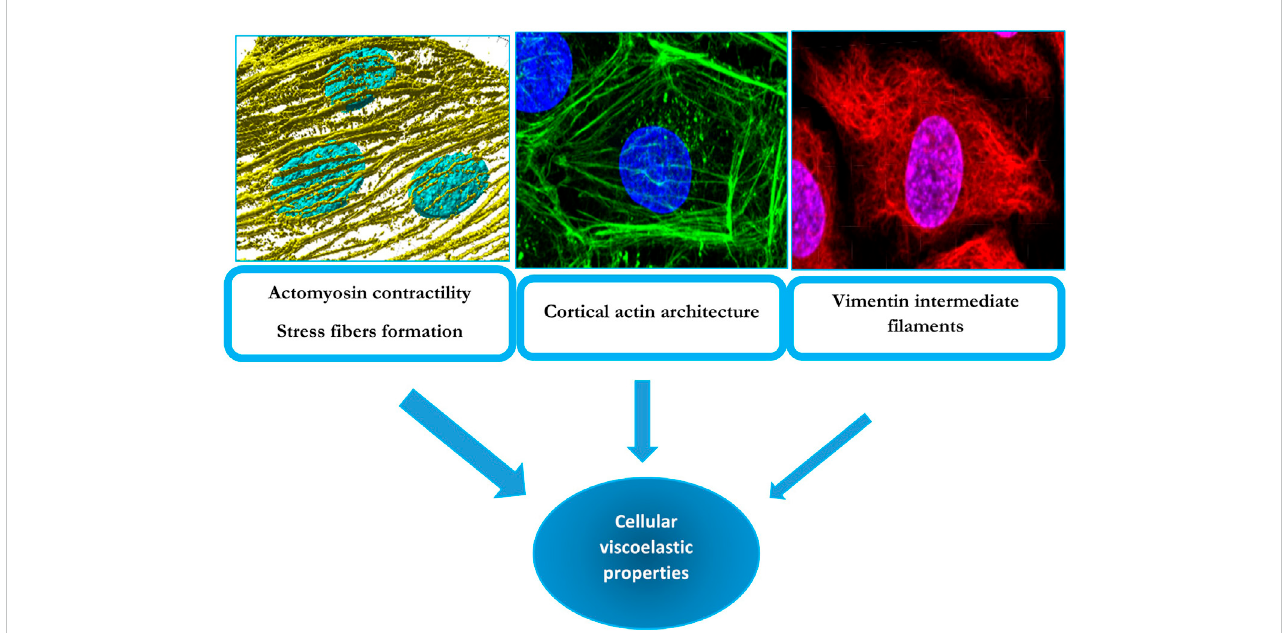
FIGURE 1 Cytoskeletal determinants of cellular viscoelastic properties: F-actin stress fi bers (left top panel), cortical actin (middle top panel) and vimentin intermediate fi laments (right top panel). The top left panel displays a 3D render of F-actin stress fi bers (yellow) and nuclei (blue) from endothelial cells undergoing alignment following exposure to laminar fl ow. These fi bers also containnon-muscle myosin and underlie cellular contractility, which has amajor contribution to endothelial biomechanics. The middle panel shows an endothelial cell with a strong cortical/junctional F-actin network (green) and nuclei (blue), which was also found to contribute to passive biomechanical properties of endothelial cells. The right panel shows an endothelial cell ’ s nuclei (blue), and vimentin intermediate fi lament network (red) which has a smaller but still signi fi cant contribution to endothelial biomechanics. The width of the arrows conveys the degree of the contribution of the particular cytoskeleton element to endothelial viscoelastic properties. The contributions of these elements to endothelial stiffness are described in Sections 2 and Section 6 of the manuscript.